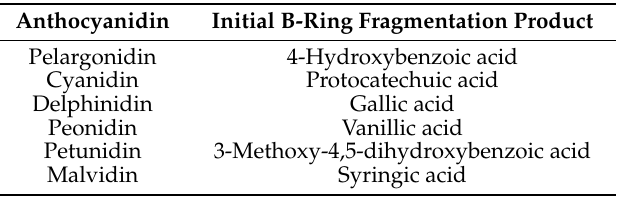
Table 2. The expected B ring fragments for the common anthocyanidins. Reproduced from the original source [110].